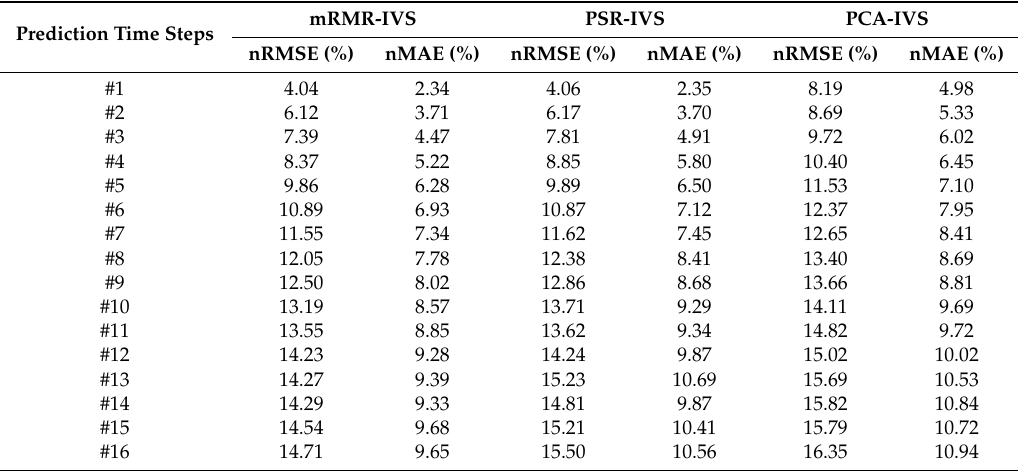
Table 5. Comparison of the multi-step ahead prediction performance of Xuqiao